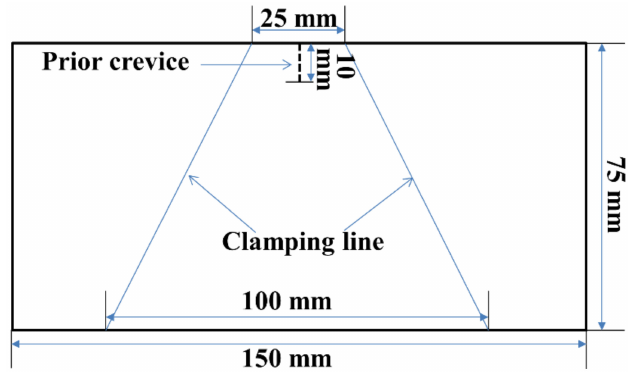
Figure 5. Specimen for tearing strength by trapezoid